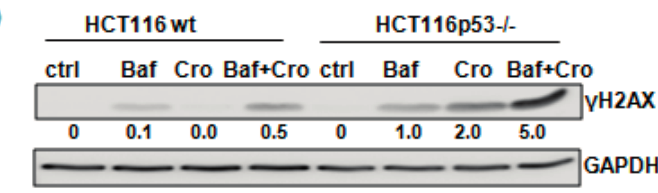
Figure 5. Crocin-induced autophagy in a p53-dependent manner. ( A ) Lysates of HCT116 wildtype and HCT116 p53 − / − , untreated (Ctrl) or treated with Bafilomycin A1 (10 nM) for 1 h and/or further treated with 10 mM crocin for 48 h, were analyzed by anti-cyclin B1, anti-phospho Histone 3 (pH3) and anti-GAPDH via Western blotting. GAPDH served as internal control for equal loading; ( B ) Quantitative analysis of percentage gated viable, necrotic, early apoptotic, and late necrotic cells in the HCT116 wild-type (wt) and HCT116 p53 − / − cells treated with Bafilomycin A1 (Baf, 10 nM) for 1 h and/or further treated with 10 mM crocin (Cro) for 48 h, measured by Annexin-PI staining; ( C ) Lysates prepared from two cell types, HCT116 wild-type (wt) and HCT116 p53 − / − , untreated (Ctrl) or treated with 10 mM crocin for 24 h and/or further treated with bafilomycin (10 nM) for 48 h, were analyzed by anti-caspase3, anti-PARP, and anti-GAPDH Western blotting. GAPDH served as the internal control for equal loading; and ( D ) Lysates prepared from two cell types, HCT116 wild-type (wt) and HCT116 p53 − / − , untreated (Ctrl) or treated with Bafilomycin A1 (10 nM) for 1 h and/or further treated with 10 mM crocin for 48 h, were analyzed by anti- γ H2AX and anti-GAPDH in Western blotting. The ratios represent protein alterations compared to the